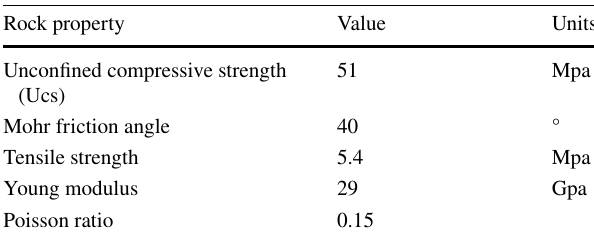
Table 1 Physical properties of the synthetic rock specimen (source: Zhang